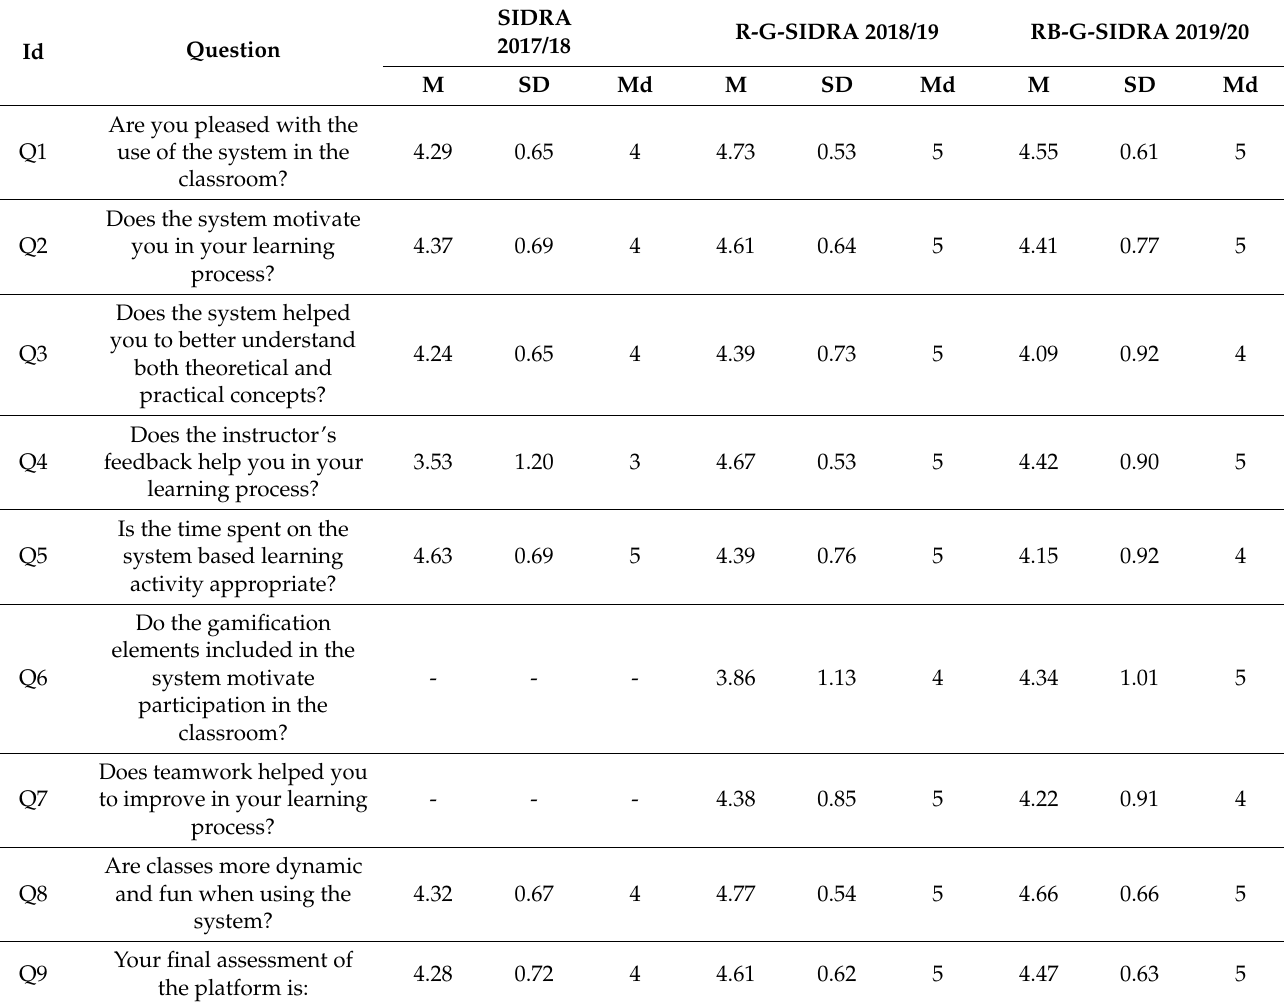
Table 5. Students’ Perceptions. “M”: Mean; “SD”: Standard Deviations; “Md”: